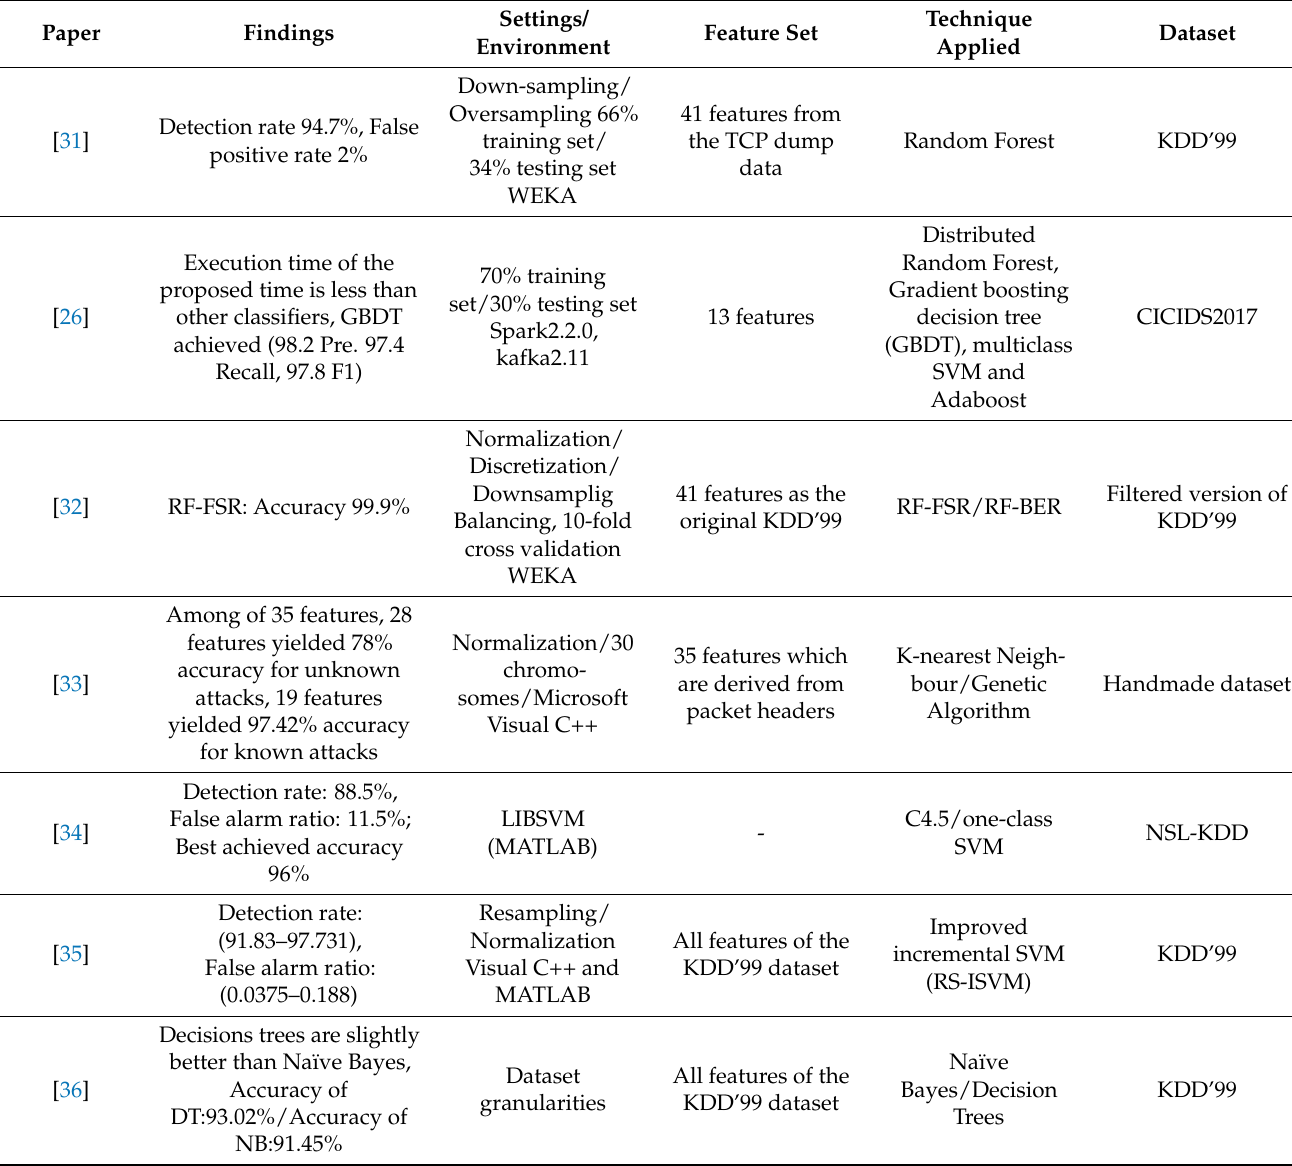
Table 1. Feature description for phishing